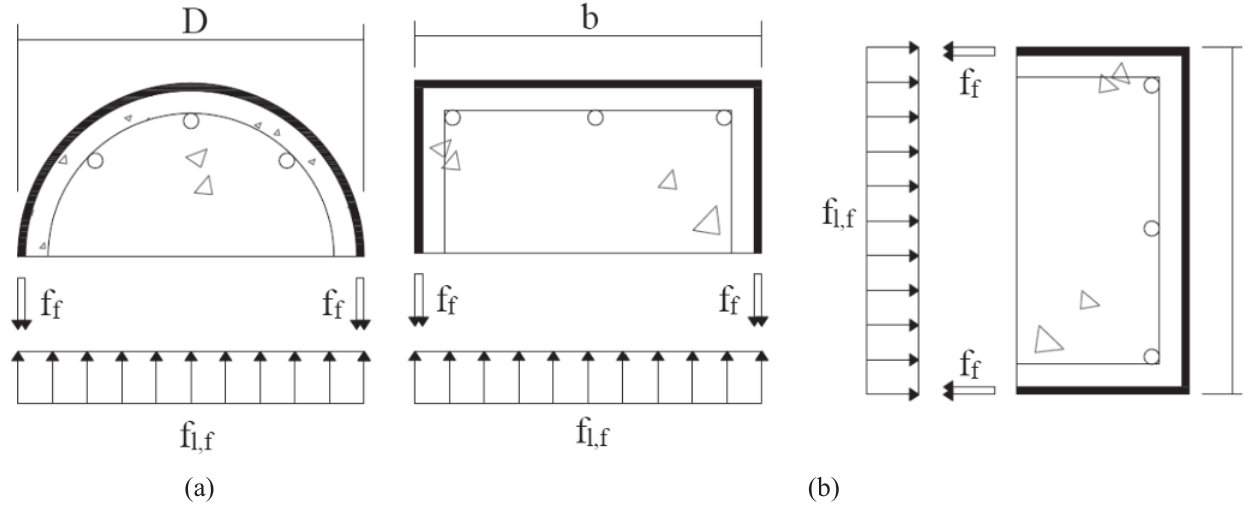
Pressão lateral exercida sobre a jaqueta de fibras de carbono. (a) Pilares circulares; (b) Pilares